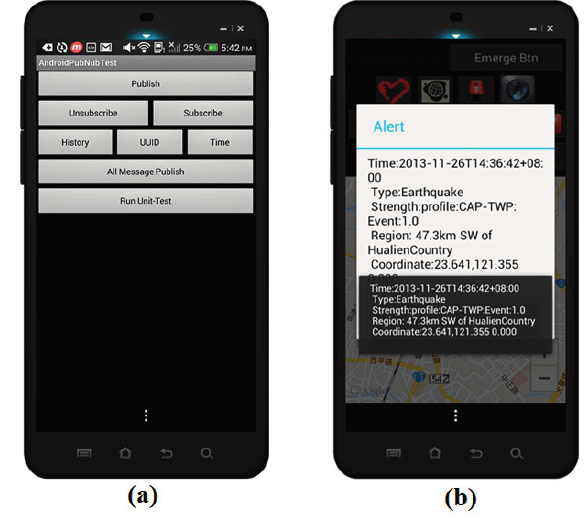
Figure 3. Deliver messages via PubNub. ( a ) PubNub broadcast; ( b ) PubNub